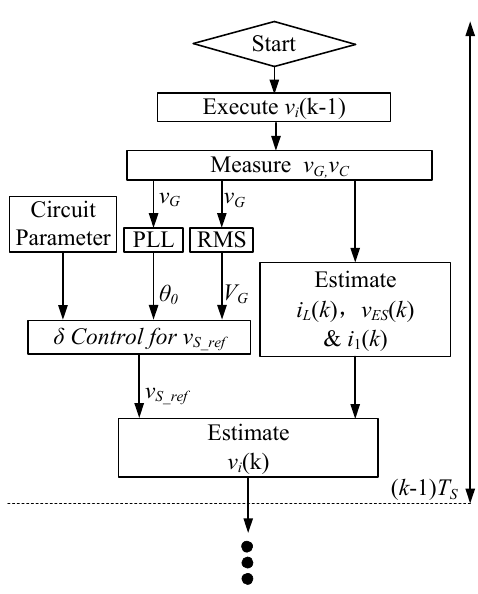
Figure 5. The program flowchart of dead-beat control and δ control.